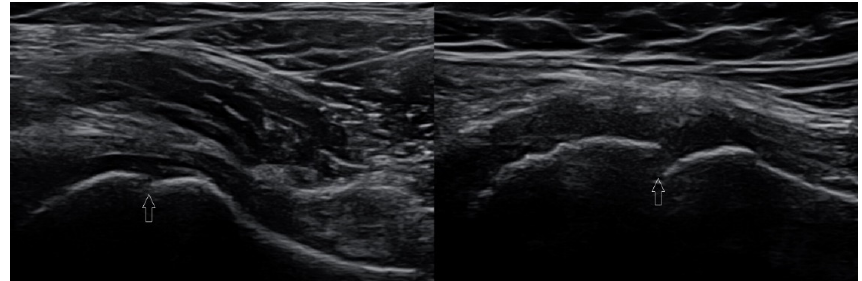
Figure 13. Image of the normal growth plates of the proximal end of the femur. Left arrow—growth plate of the femoral head (probe positioned along the long axis of the femoral neck); right arrow— growth plate of the greater trochanter (long axis view in the frontal plane). Linear probe 3–12 MHz.